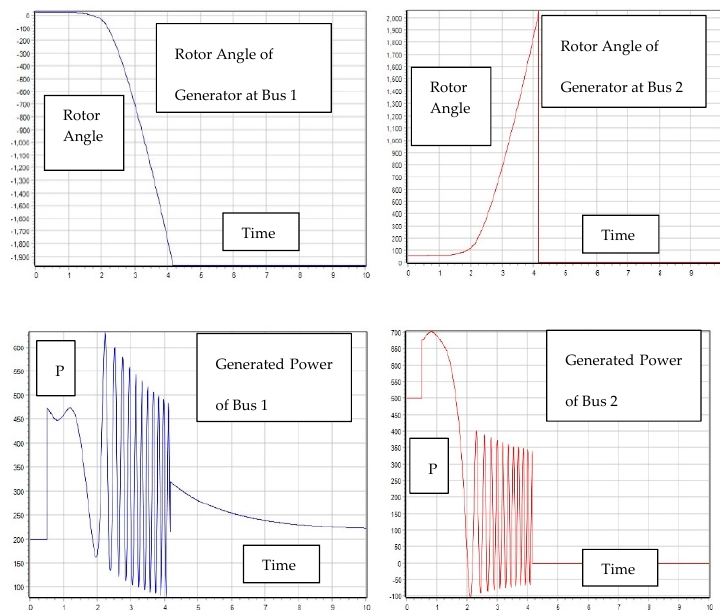
Figure 16. Rotor angle and generated power of generators of buses 1 and 2.